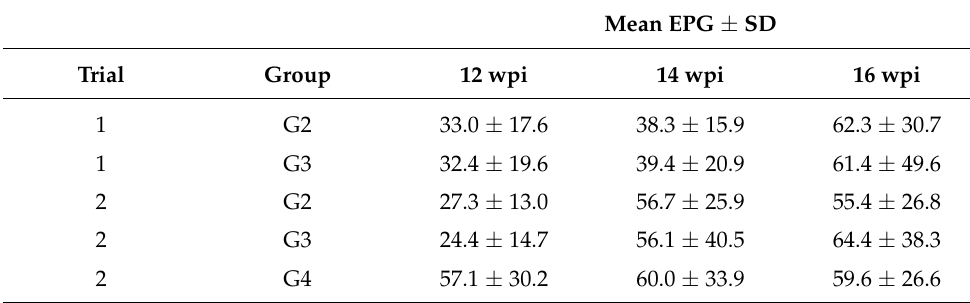
Table 2. Faecal egg count (FEC) represented as egg per gram (EPG).